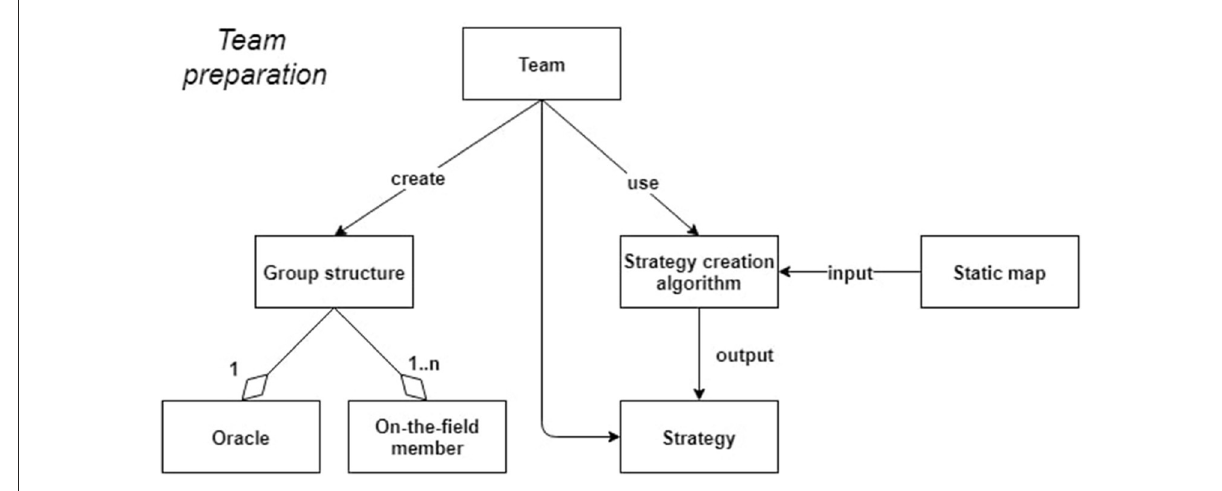
FIGURE2 Smart Rogaining team preparation.